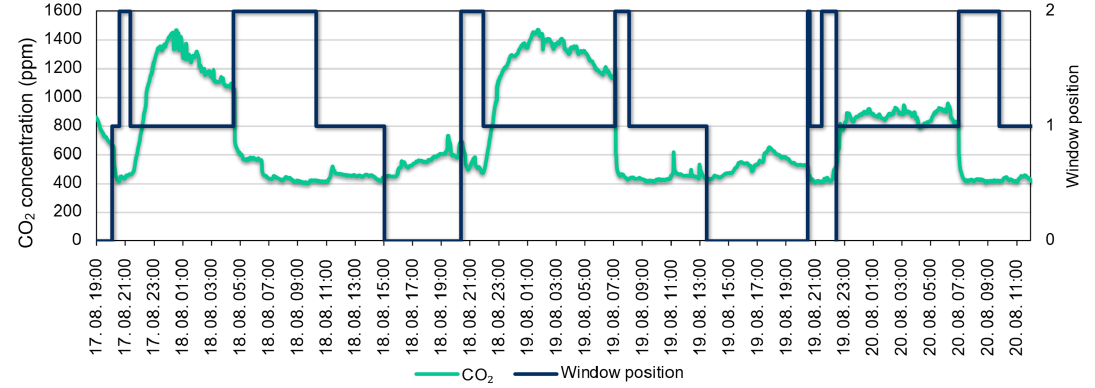
Figure 15. CO 2 values in the small bedroom and window position (“0”—closed, “1”—tilted, “2”—fully open).